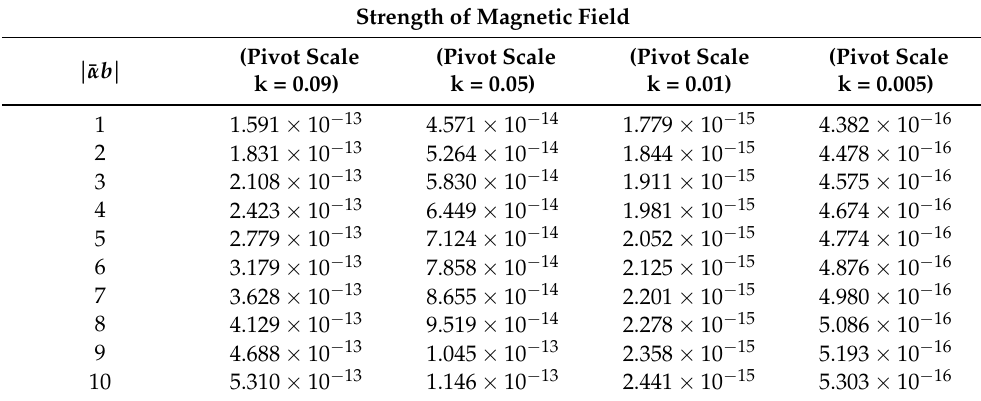
Table 1. The numerical estimations of present day magnetic field strength in Gauss is being presented for different choices of the parameter ¯ α b for five different choices of the pivot scale k (in Mpc − 1 ). As evident for smaller values of the parameter | ¯ α b | as well as choice of the pivot scale, the magnetic field strength decreases. See text for more discussion.